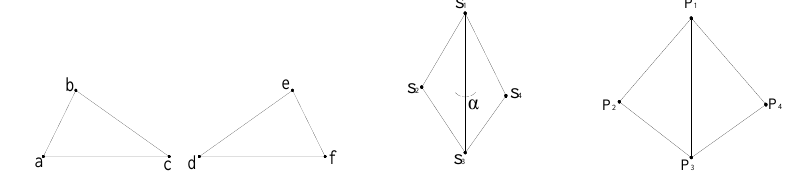
Fig. 2. Recessive deformation of triangles. Fig. 3. Expanded deformation between